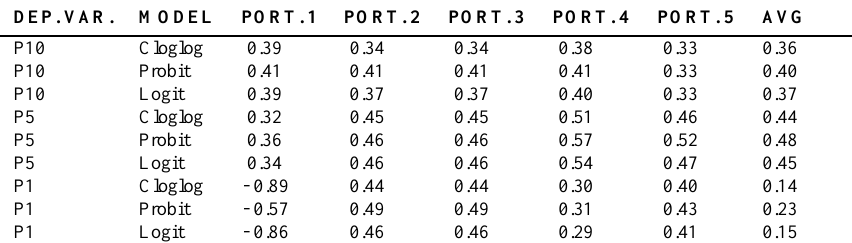
Table 13. Results for the Gini coefficient analysis for the portfolios. Out-of-sample analysis DEP.